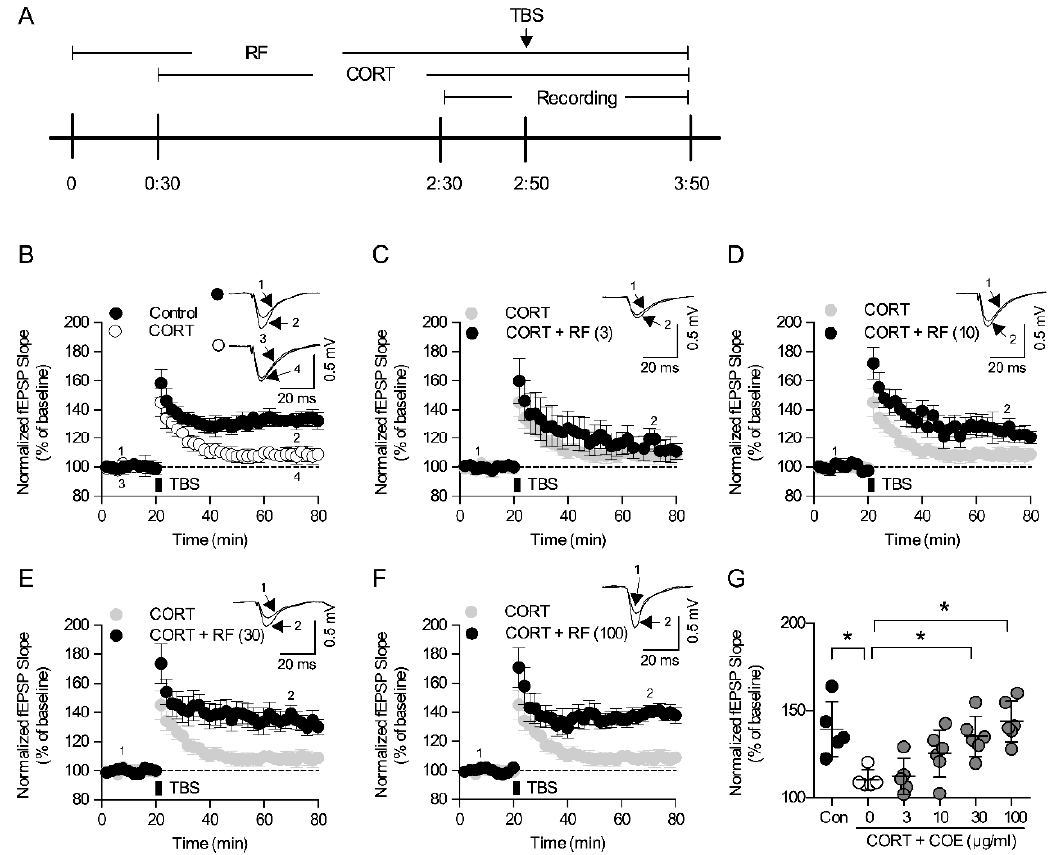
Figure 6. Effect of rubrofusarin on corticosterone-induced synaptic deficit: ( A ) Schematic diagram of experimental schedule. Hippocampal slices were treated with rubrofusarin (RF) from 30 min before corticosterone (CORT) treatment. HFS was delivered to the slices 30 min after the CORT treatment. ( B ) Normalized fEPSP slop of control and CORT (1 µM) group for 80 min. ( C ) Normalized fEPSP slop of CORT + RF (3 µM) group for 80 min. ( D ) Normalized fEPSP slop of CORT + RF (10 µM) group for 80 min. ( E ) Normalized fEPSP slop of CORT + RF (30 µM) group for 80 min. ( F ) Normalized fEPSP slop of CORT + RF (100 µM) group for 80 min. Data represented as mean ± SD. ( G ) Normalized fEPSP slop of each group during last 10 min. Data represented as mean ± SD with raw data. * p < 0.05.